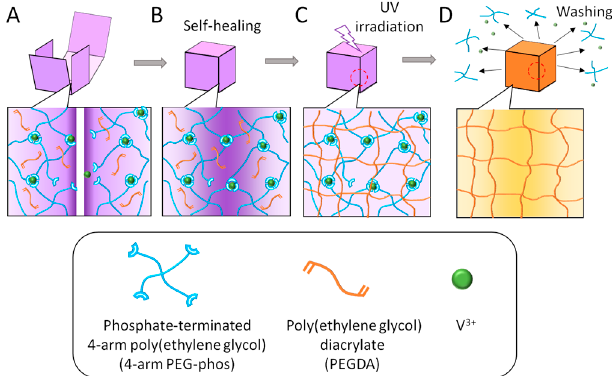
Figure 1. Fabrication processes of 3D hydrogel object using self-healing template (SHT). ( A ) The SHT